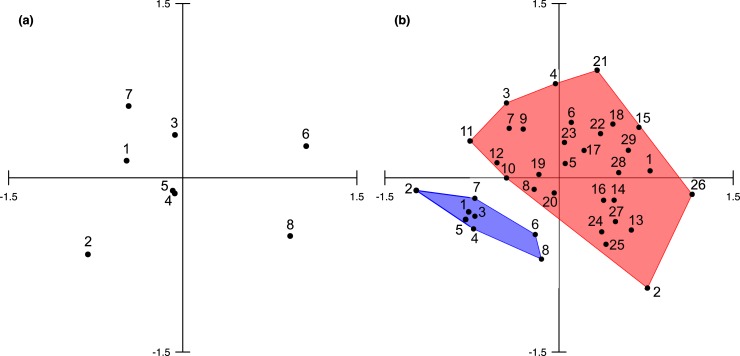
nMDS of Bray-Curtis dissimilarity distances.(a) Al Wajh sites based on both UVS and ichthyocide surveys. Stress: 0.1631. (b) Al Wajh sites (blue) and Coker et al. [29] sites (red) based only on ichthyocide surveys. Stress: 0.2064.